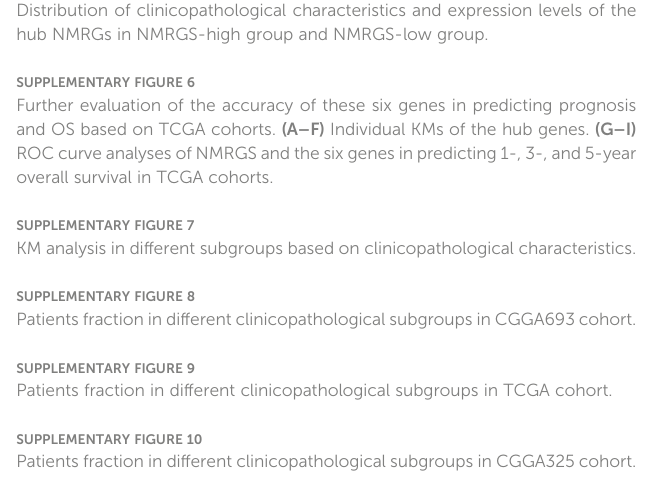
SUPPLEMENTARY FIGURE 20 Western blots of the hub genes in cell